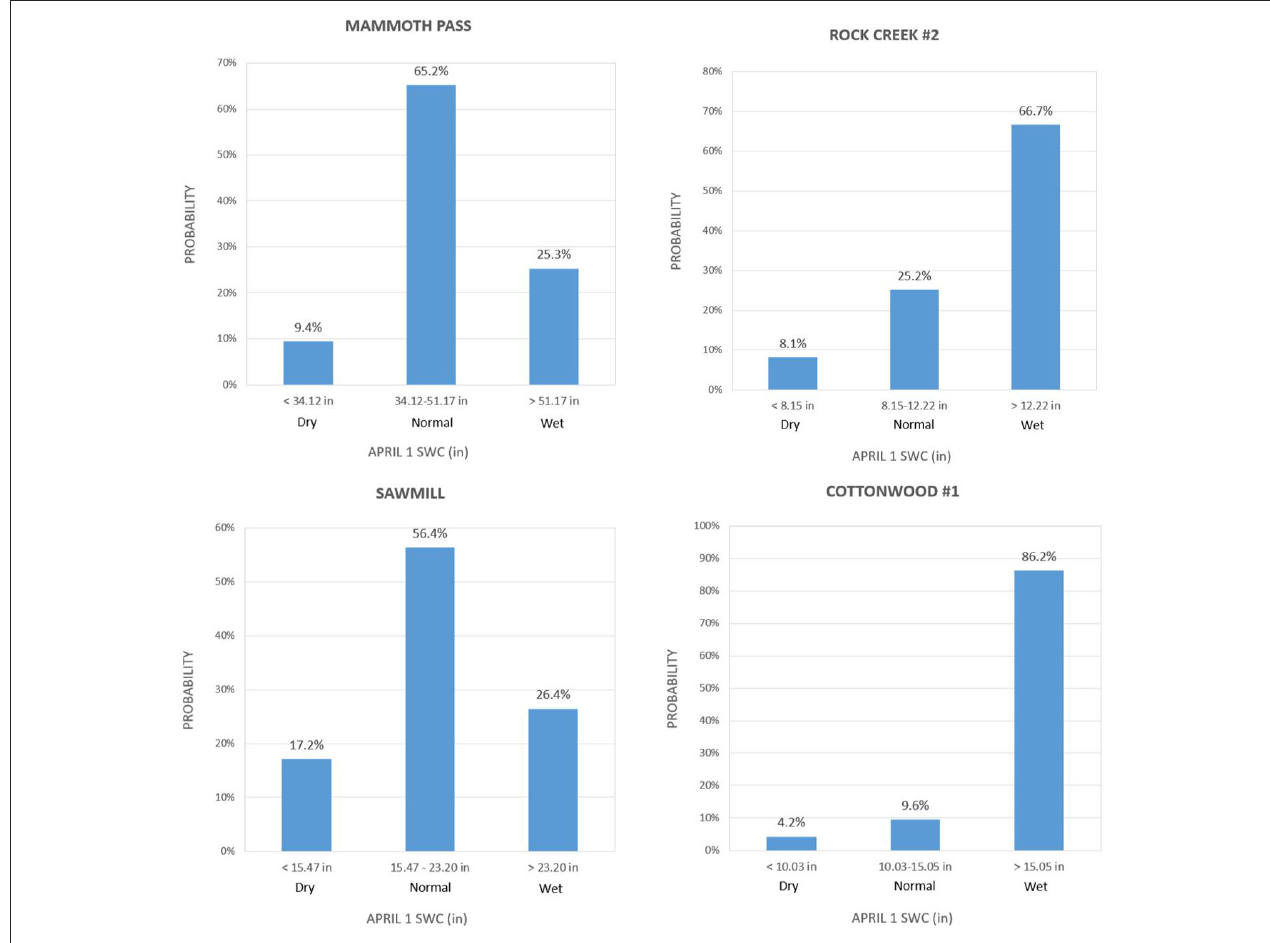
FIGURE 6 | Probability of April 1 SWC falling into each of the categories – dry, normal, or wet – issued by the Categorical Model for